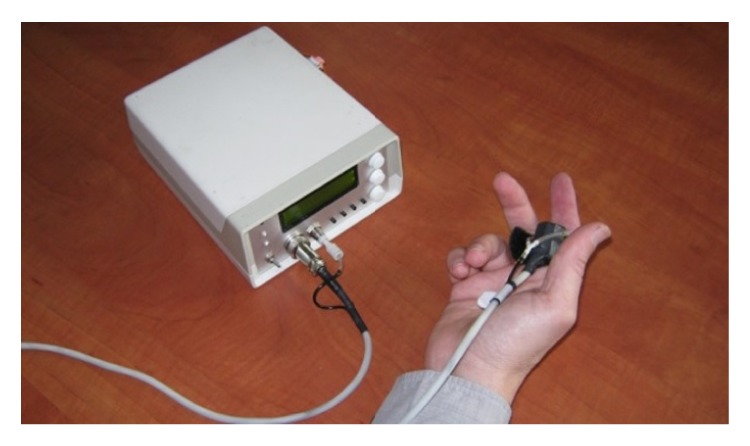
Device application.